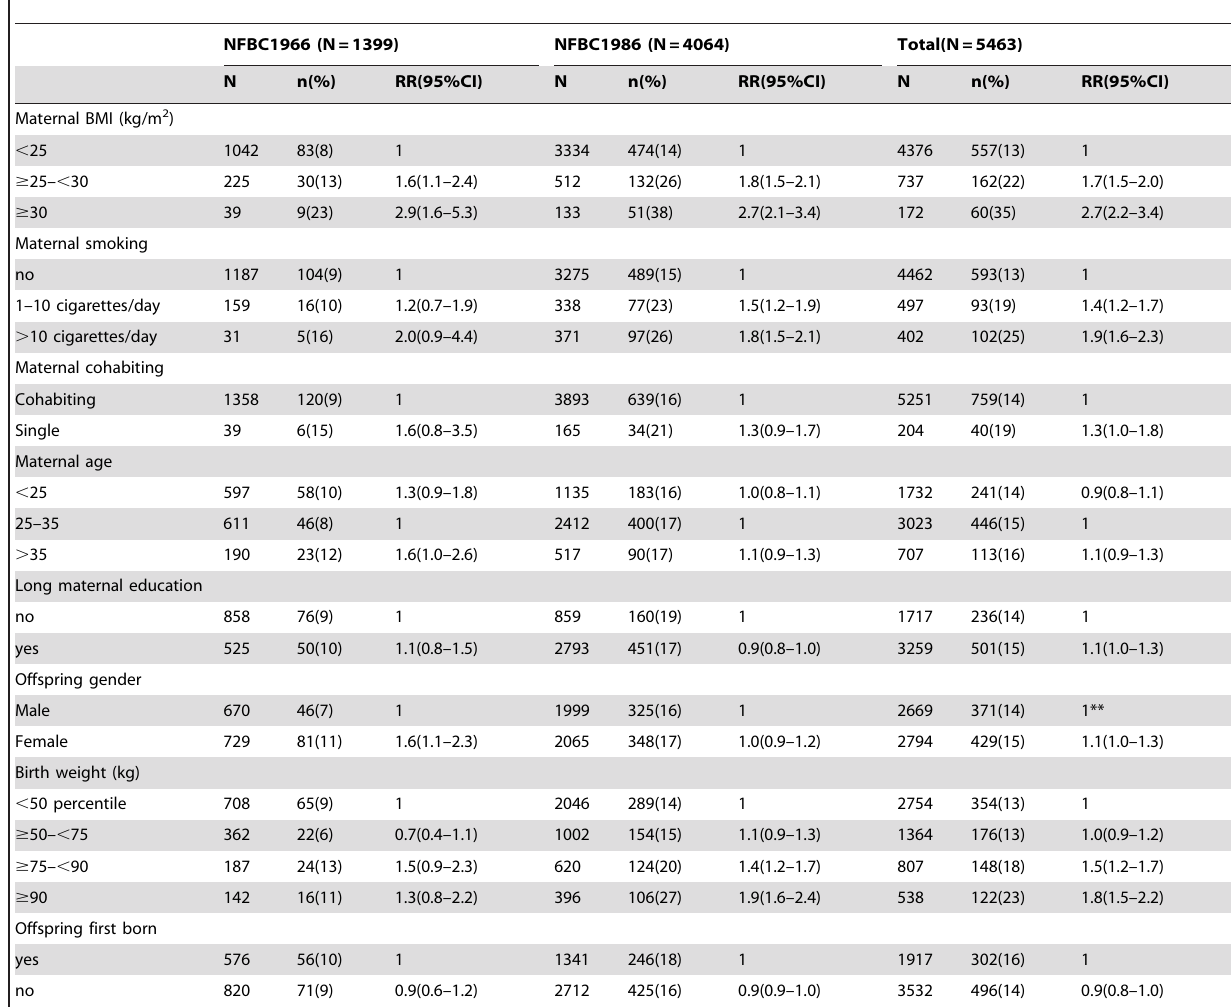
Table 4. Relative risk of overweight at the age of 9 years according to the IOTF associated with pre- and perinatal risk indicators in the NFBC1966 and the